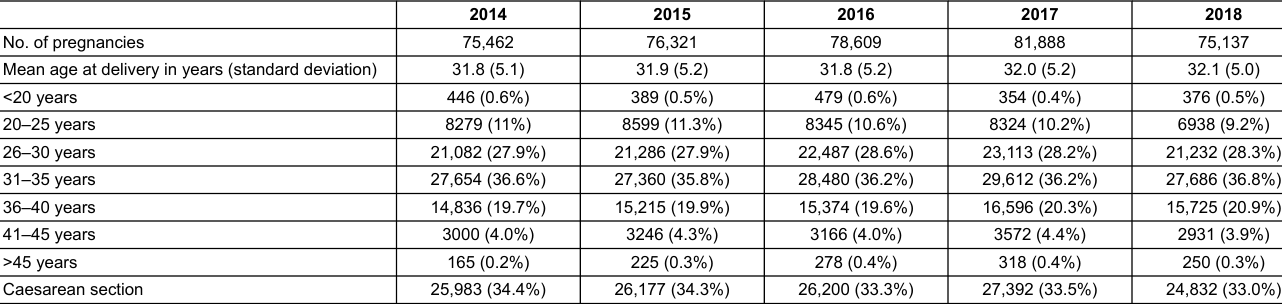
Table 1: Demographics of the weighted pregnancy population (2014–18)